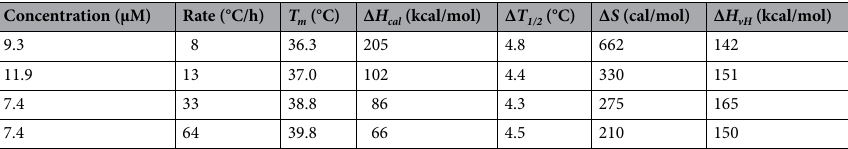
Table 2. Thermodynamic parameters associated with the nsP4-CHIKV thermal denaturation by DSC. T m represents the temperature where C P reaches its maximum value. Δ H cal was calculated as the area under the DSC trace. Δ T 1/2 corresponds to the linewidth at half the height of the transition peak. The entropy change at T m , Δ S , was calculated as Δ S = Δ H cal / T m . Δ H vH was calculated as 4 RT m2 C p,max /Δ H cal . Analyses of the thermograms were performed with MicroCal Origin software. Uncertainties: T m (± 0.2 °C), Δ H cal (± 1 ‒ 3 kcal/ mol), Δ T 1/2 (± 0.2